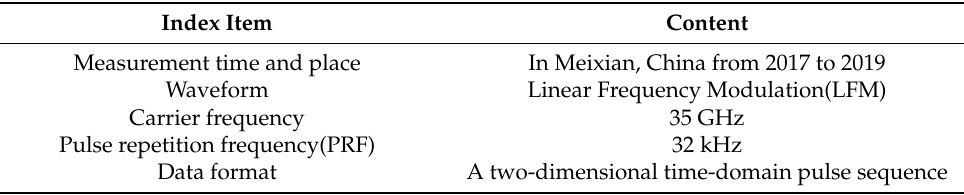
Table 1. The main information of the